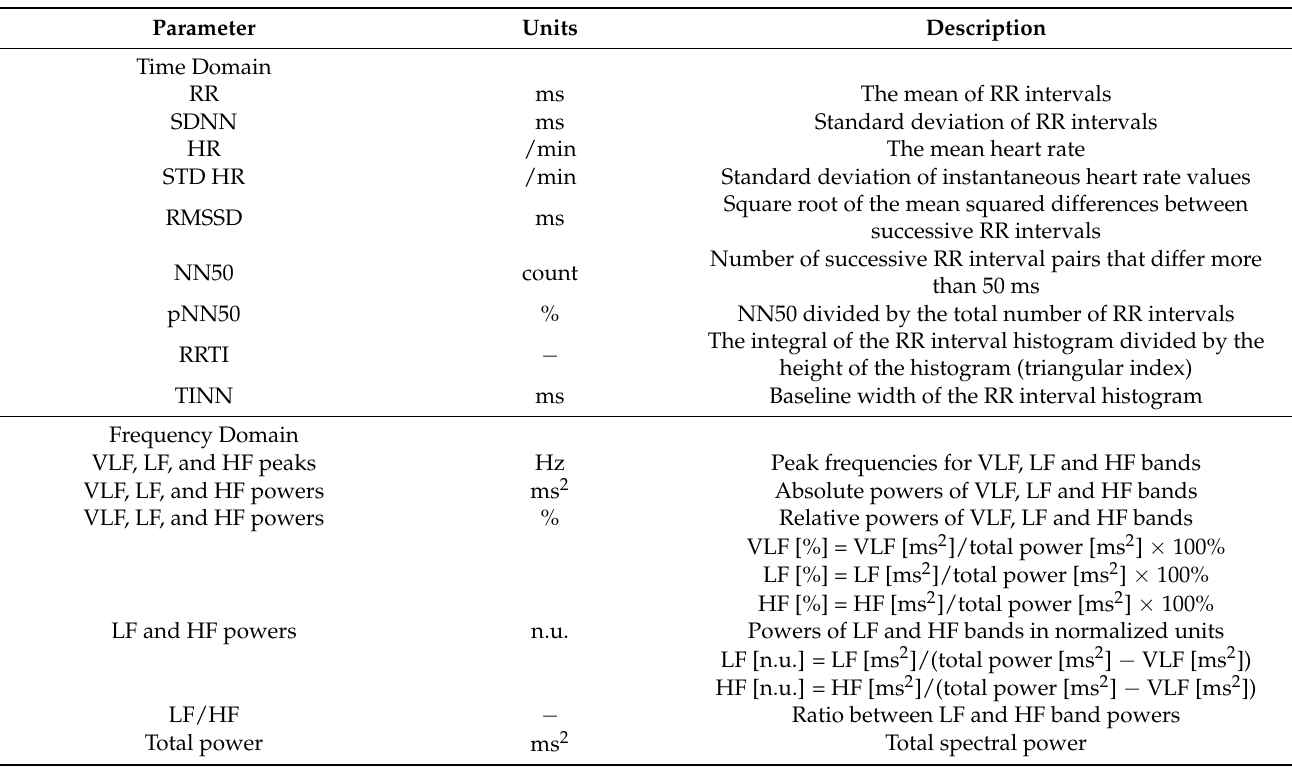
Table 1. Summary of HRV parameters calculated by Kubios HRV software [29]. Parameter Units